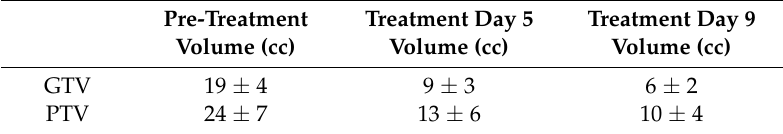
Table 6. Target volume reductions during treatment as determined by CT contoured